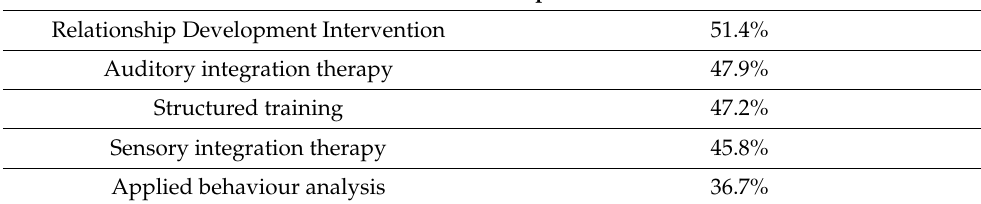
Table 4. Awareness of approaches devoted to the care of individuals with autism. Are You Aware of the Following Intervention and Approaches Devoted to the Care of Individuals with Autism Spectrum